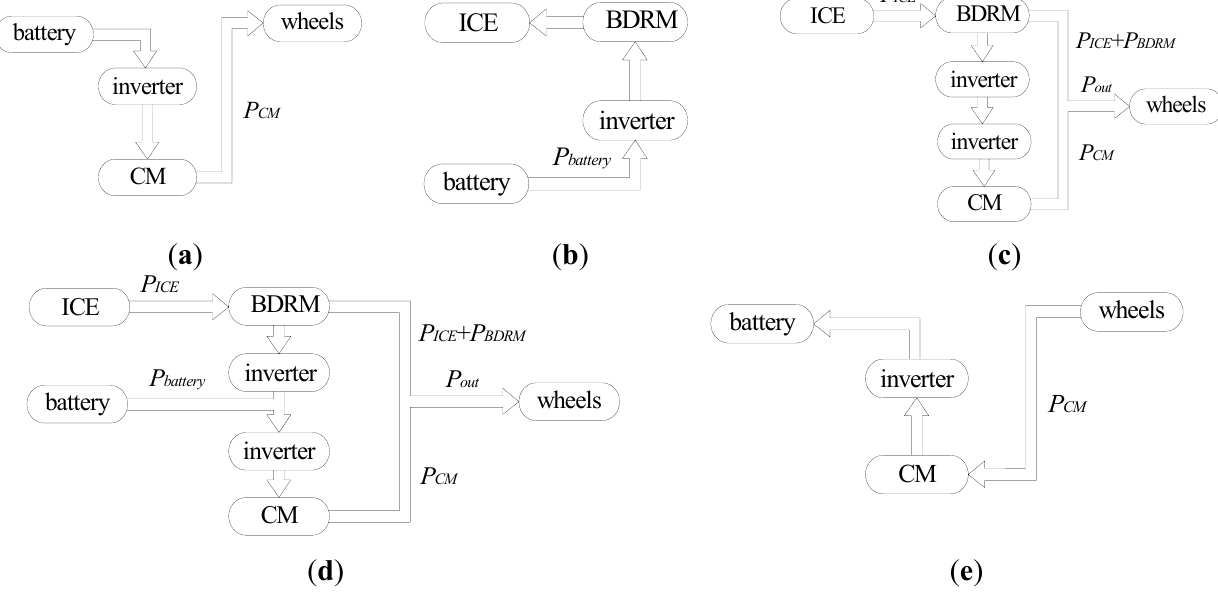
Figure 4. Typical operation states of the power-split hybrid drive system: ( a ) Pure electric mode; ( b ) ICE starter mode; ( c ) CVT mode; ( d ) Acceleration and hill climbing mode; ( e ) Braking